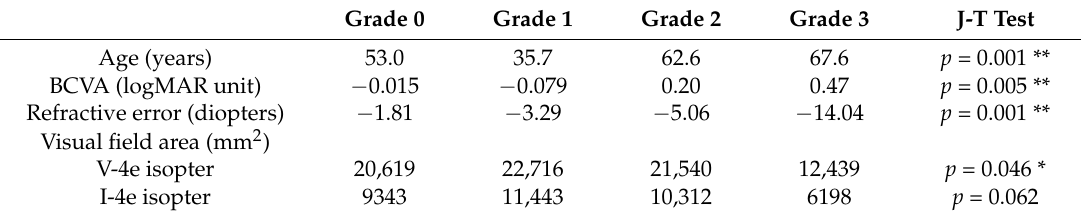
Figure 6. Correlation between refractive error and visual function among carrier female subjects. The graphs show visual acuity values expressed in logMAR units ( a ), visual field extent with the V-4e isopter ( b ), and visual field extent with the I-4e isopter ( c ) versus refractive error. The data from the same subject are indicated using bars connecting the points. Table 4. Relation of fundus grade and visual function in female carriers.